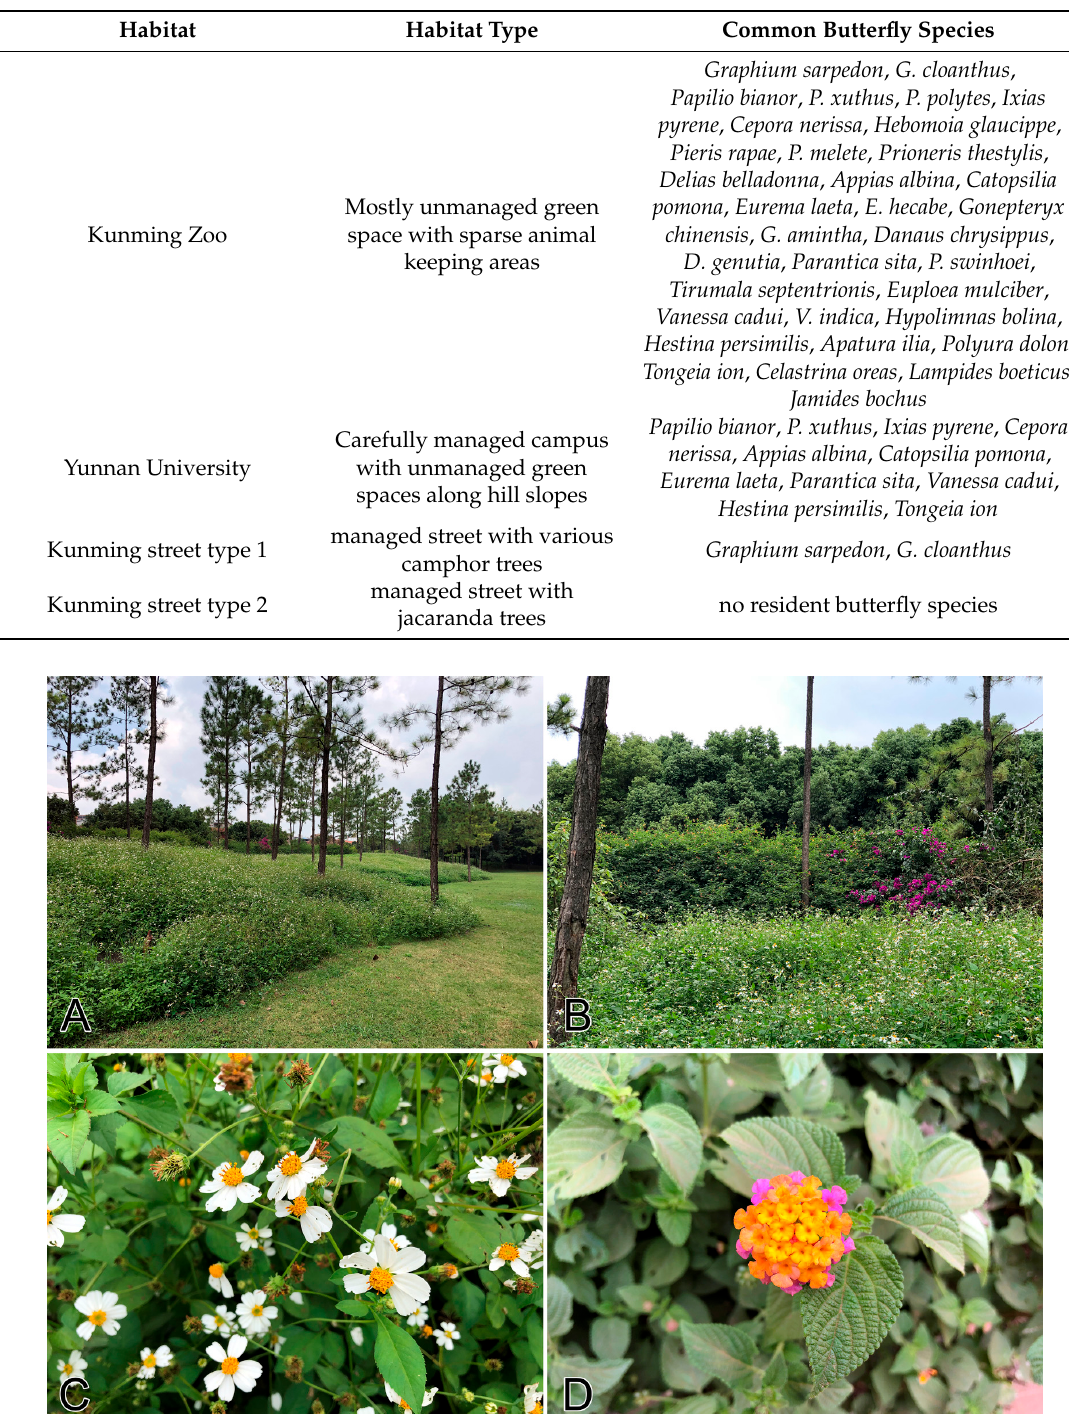
Table 3. Inhabiting butterfly fauna observed in four types of urban habitats in Kunming downtown area.